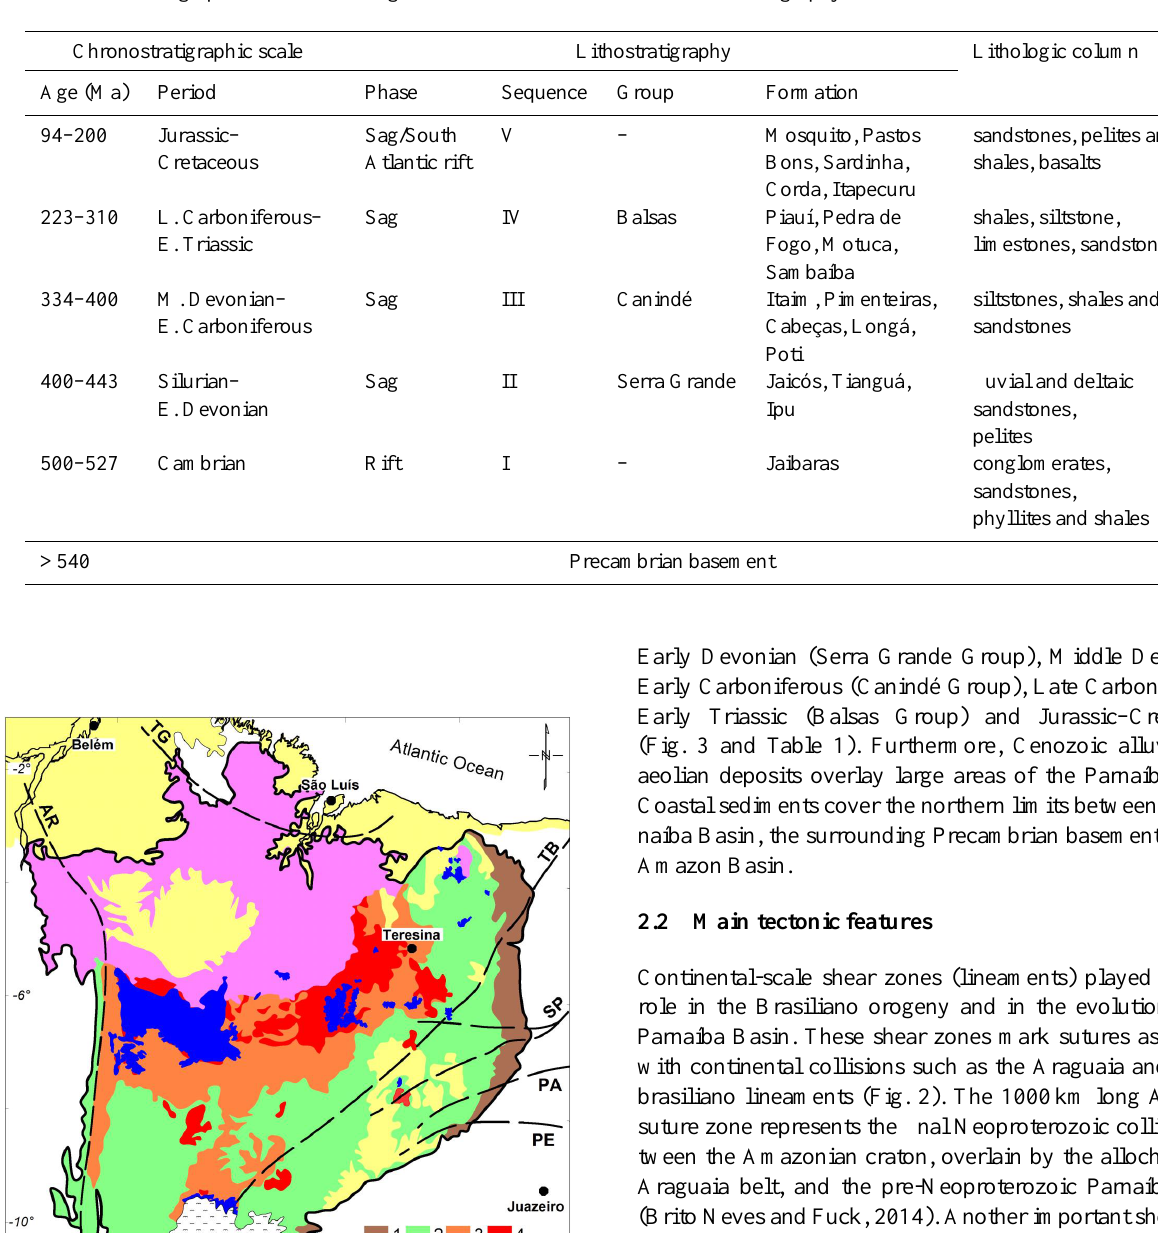
Table 1. Chronostratigraphic chart illustrating various divisions of the Phanerozoic stratigraphy of the Parnaíba basin.